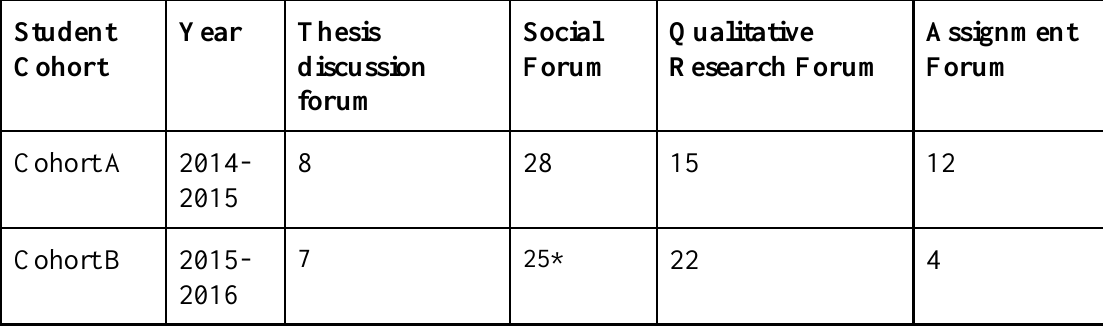
Table 3: Number of Posts to Loop Online Fora